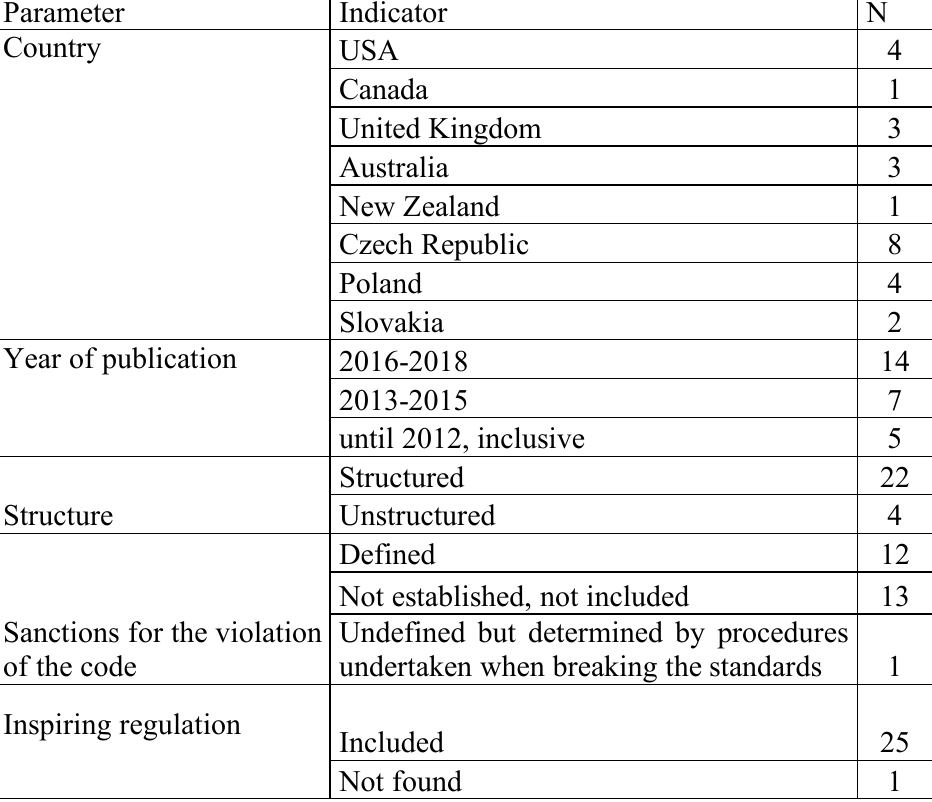
Table 1: Basic characteristics of ethics codes